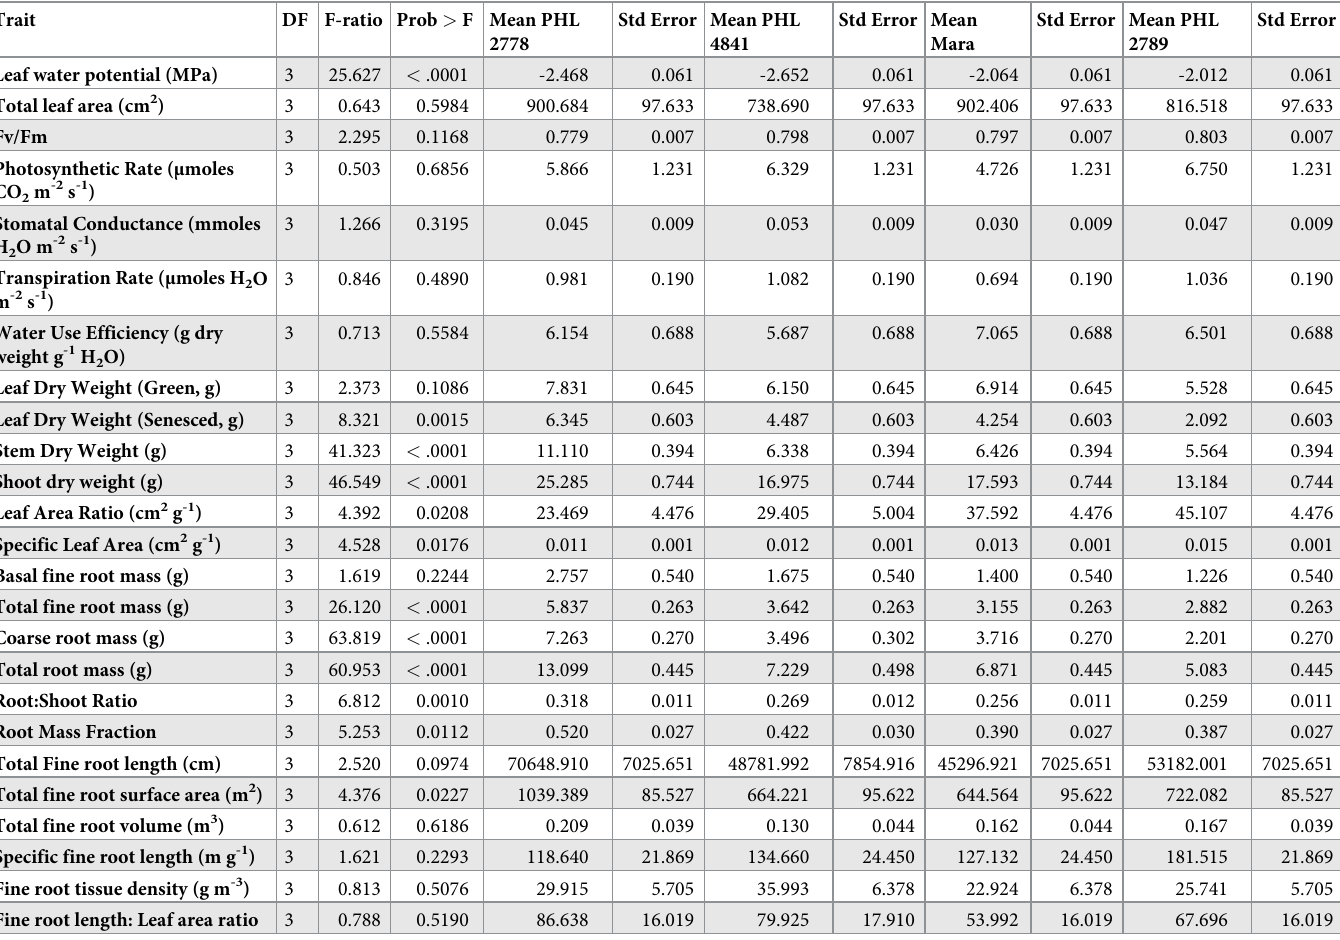
Table 2. ANOVA of physiological traits of plants under water stress in response to Genotype during the water stress phase. Trait DF F-ratio Prob > F Mean PHL 2778